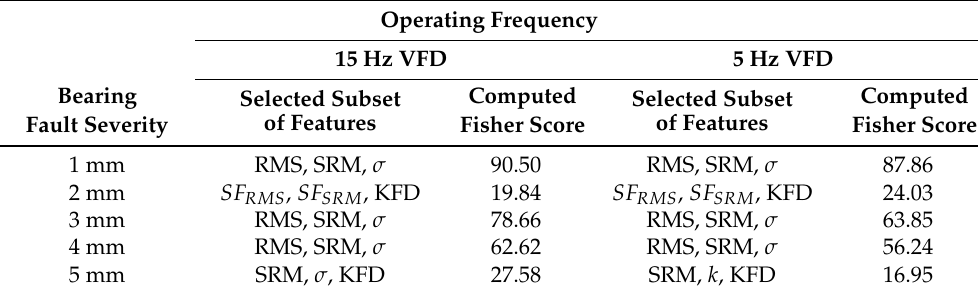
Table 4. Detail of the selected subsets integrated by considering combinations of three statistical time features in the Fisher score analysis for a power supply frequency of 15 Hz, and 5